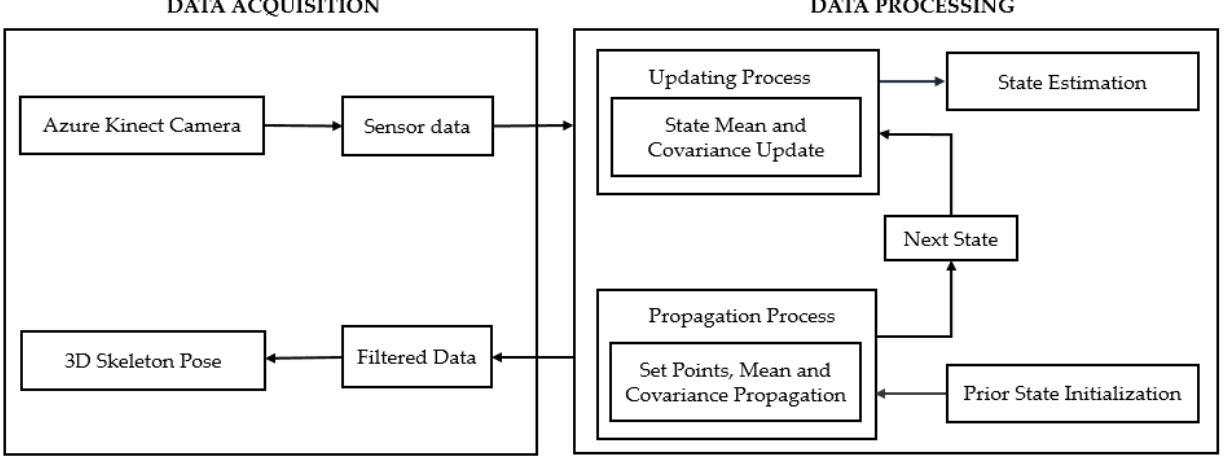
Figure 1. Flowchart of a sensor system based on the RUKF.